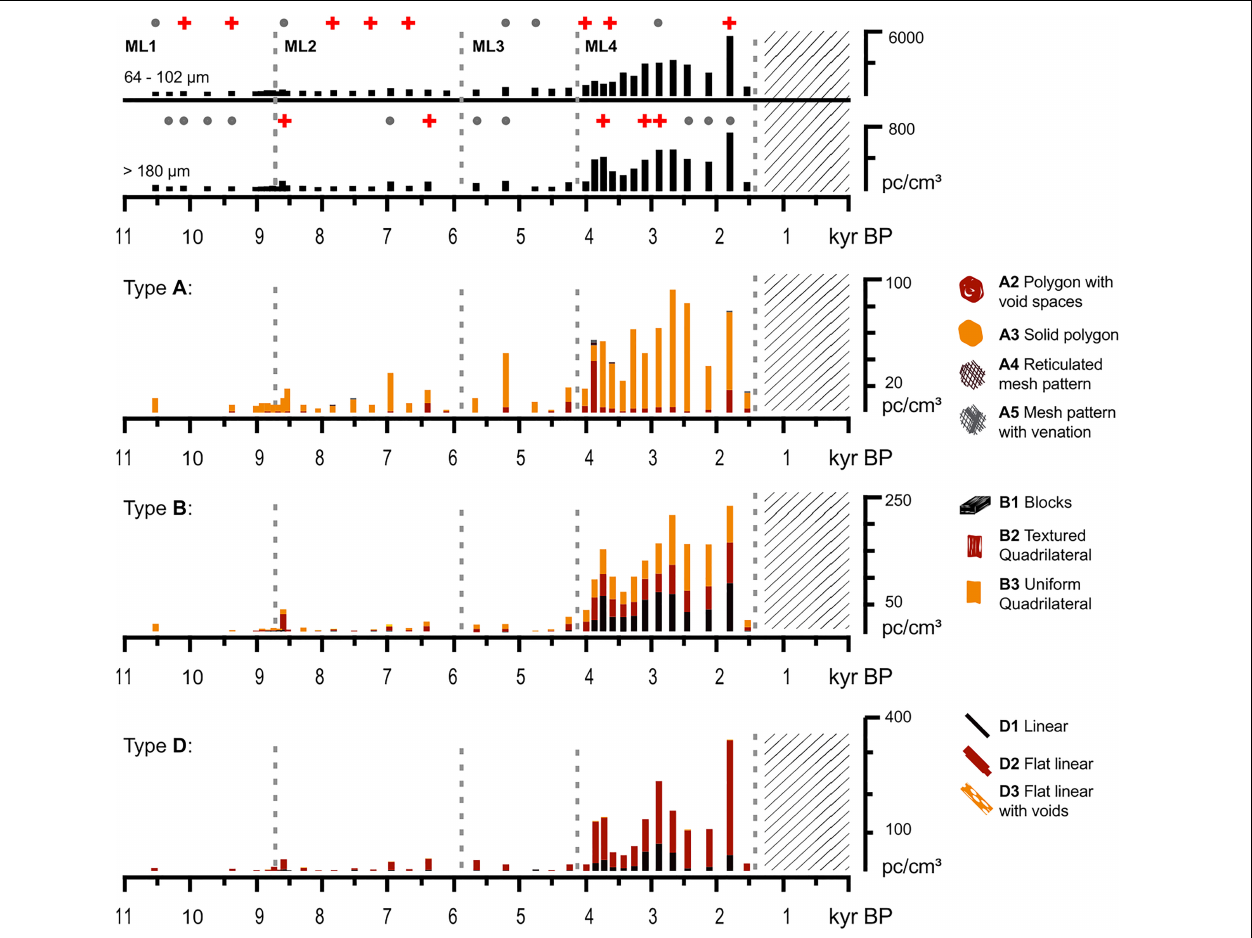
FIGURE 5 | Charcoal concentration and morphotypes found in MAR19-II core from Monquentiva. The top two panels show total charcoal concentration for micro (64–102 µ m) and macrocharcoal ( > 180 µ m). Red crosses and gray dots represent significant and non-significant fire peaks from CharAnalysis (Higuera et al., 2009), respectively. The bottom three panels show most abundant charcoal morphotypes from MAR19-II core presented as concentration. Dashed gray lines indicate the limits for Monquentiva local pollen zones ML1 to ML4 from the CONISS zonation. The lattice denotes a gap in the MAR19-II sedimentary